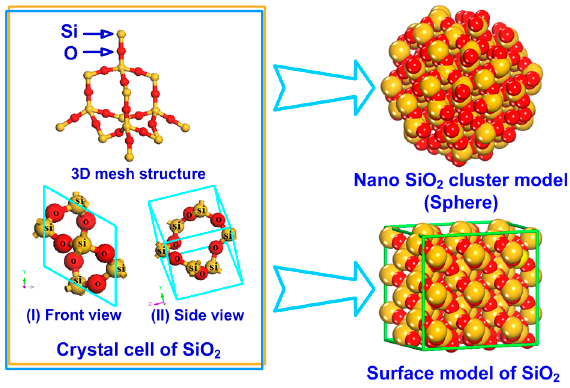
Figure 8. The molecular model of nano-SiO 2 .